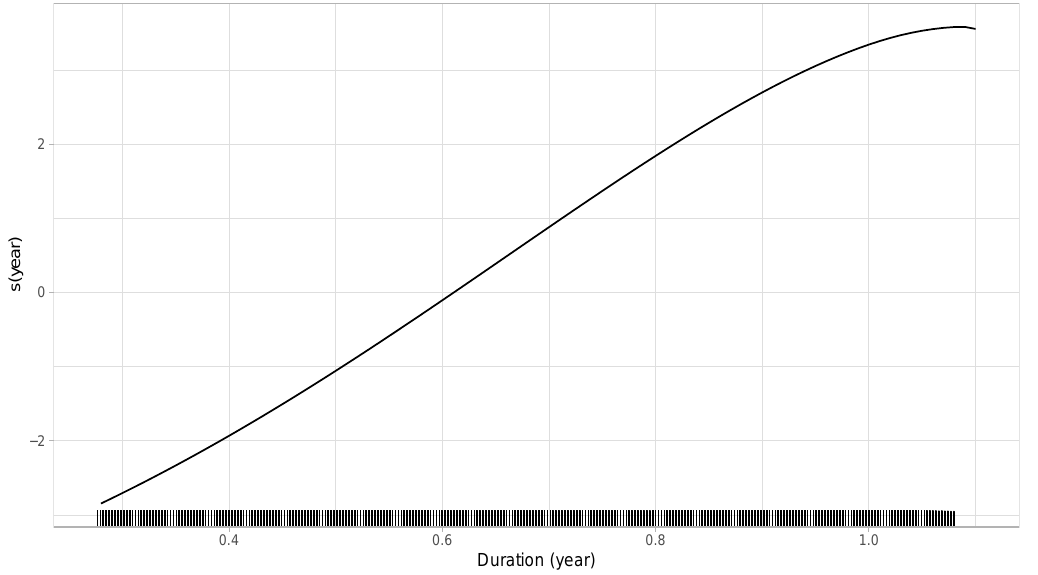
Figure 11. ˆ s 2 ( year ) from the GAMLSS with random effects model estimated with Canadian